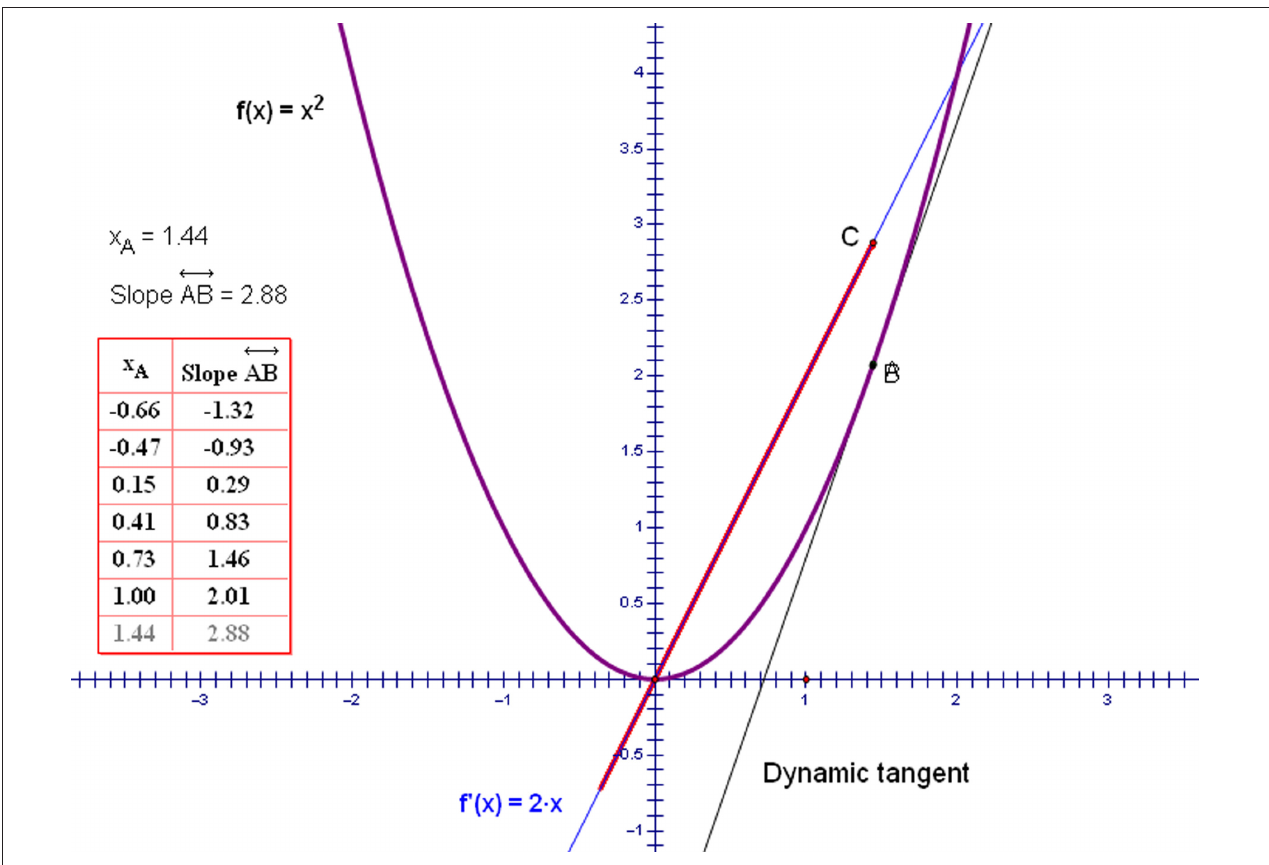
FIGURE 8: Generation of the rate of change or slope function in